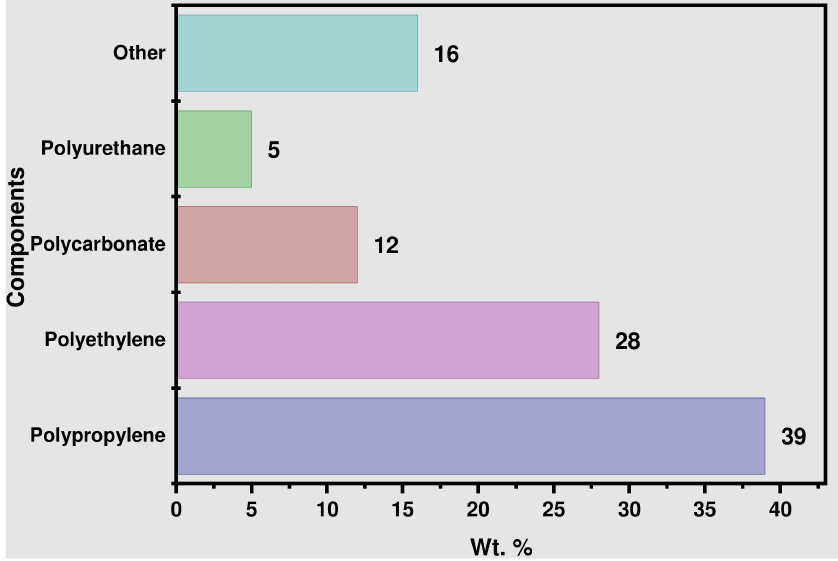
Figure 4. Different types of plastics found in ASRs. (Adapted from Hemati, et al.